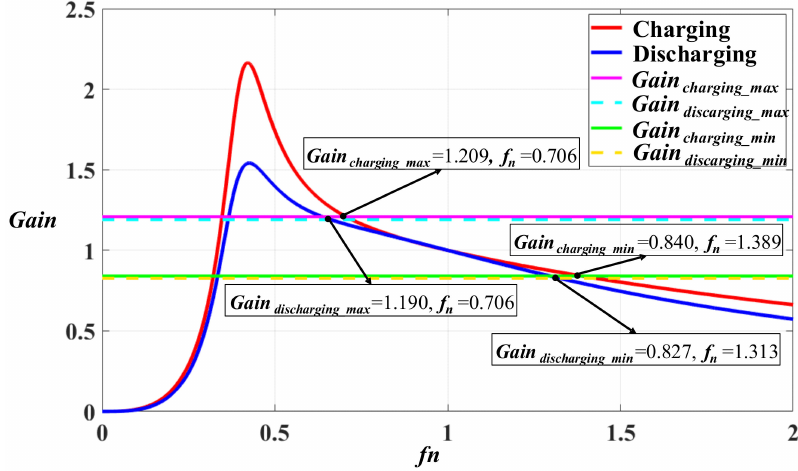
Figure 11. Voltage gain curves under the charging and discharging